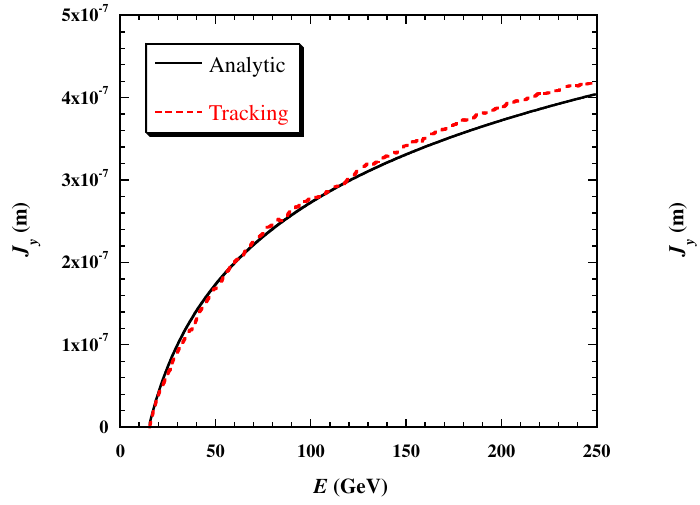
FIG. 1. Action induced by cavity tilt 15 (cid:10) rad (RMS), as a function of beam energy. Results of tracking simulation (solid line) and the analytic formula (dashed line) for the ILC main